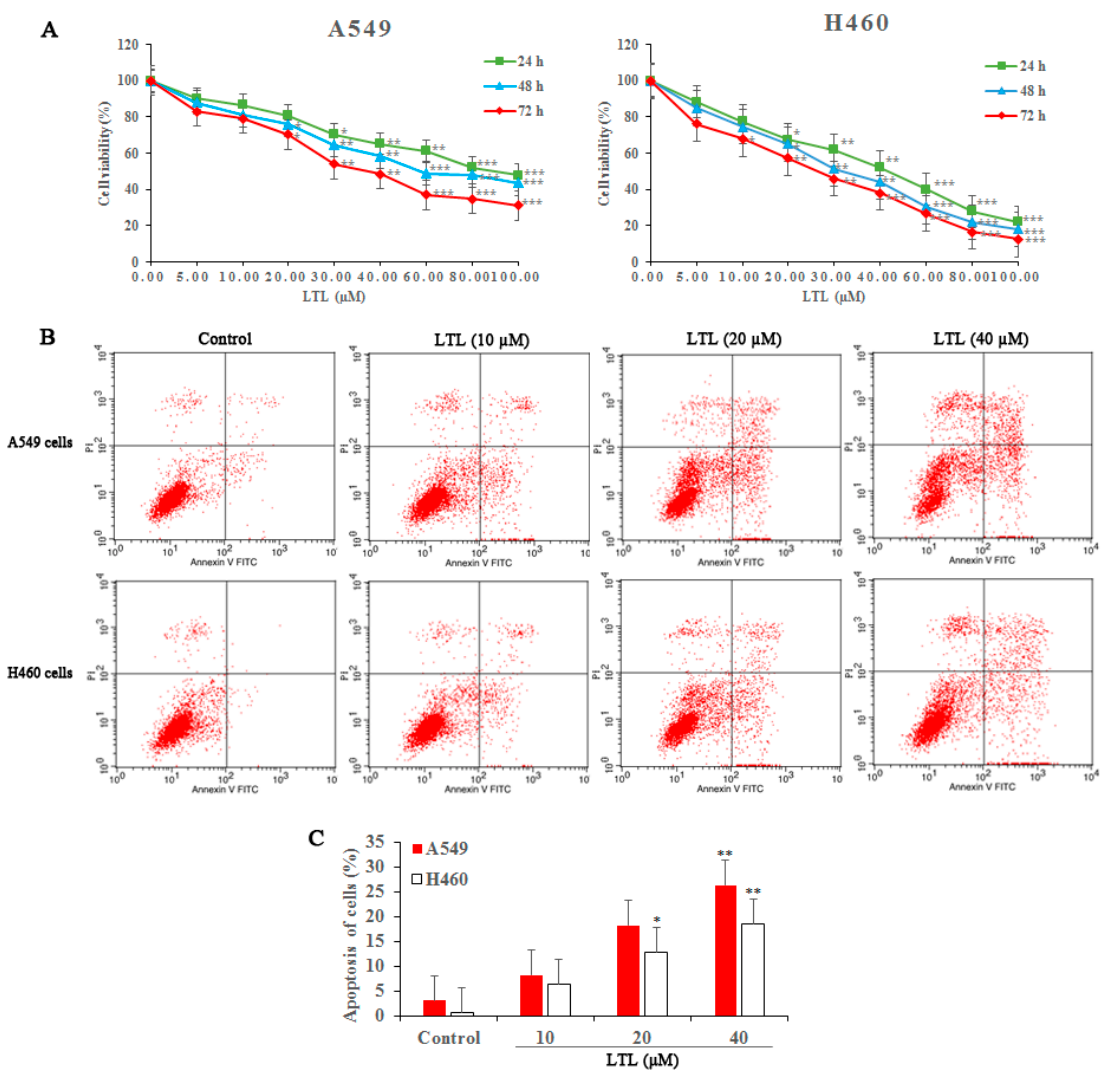
Figure 1. Luteolin (LTL) inhibits proliferation of and induces apoptosis in A549 and H460 cancer cells. ( A ) Cell proliferation was measured with a cell counting kit-8 (CCK-8) assay when A549 and H460 cancer cells were treated with LTL at various concentrations (5, 10, 20, 30, 40, 60, 80, and 100 µ M) for up to 72 h; ( B ) Apoptosis of A549 and H460 cells was quantified 24 h after treatment with LTL at various concentrations (10, 20, and 40 µ M) by Annexin V-Fluorescein (FITC)/Propidium Iodide (PI) double-staining; ( C ) Bar graphs represent the proportion of early and late stage apoptosis cells. The results are expressed as means ± Standard Deviation (SD) of three independent experiments. * p < 0.05, ** p < 0.01, *** p < 0.001 compared with the controls.